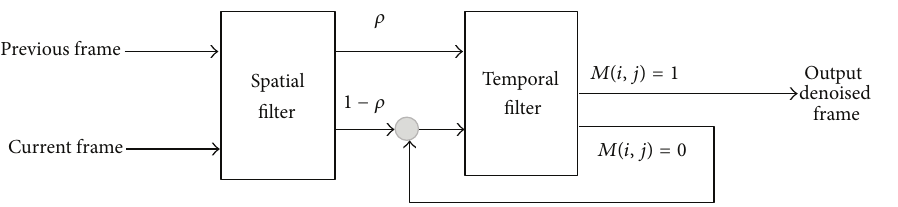
Figure 2: Block diagram of the spatial-temporal